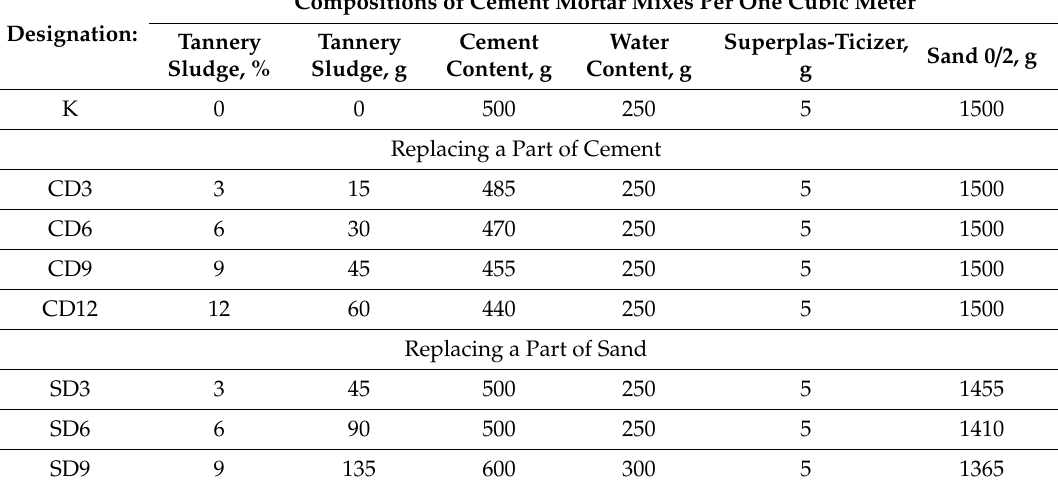
Table 4. Compositions of cement mortar